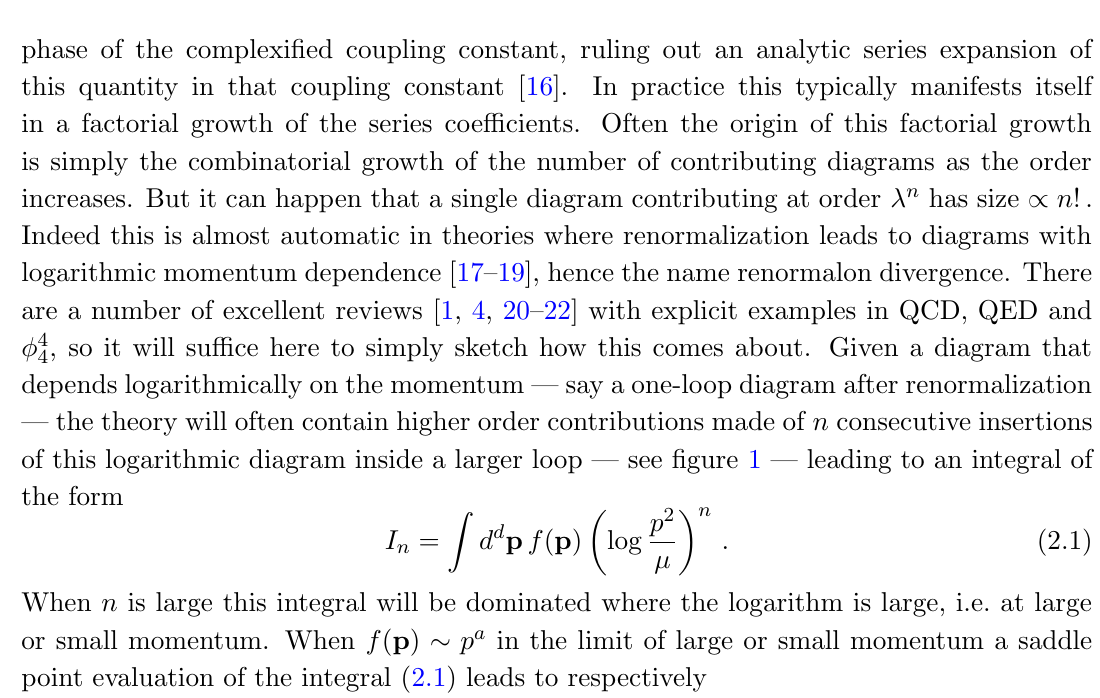
Figure 1 . Left: a renormalized 1-loop diagram. Right: n renormalized 1-loop diagrams inside a larger